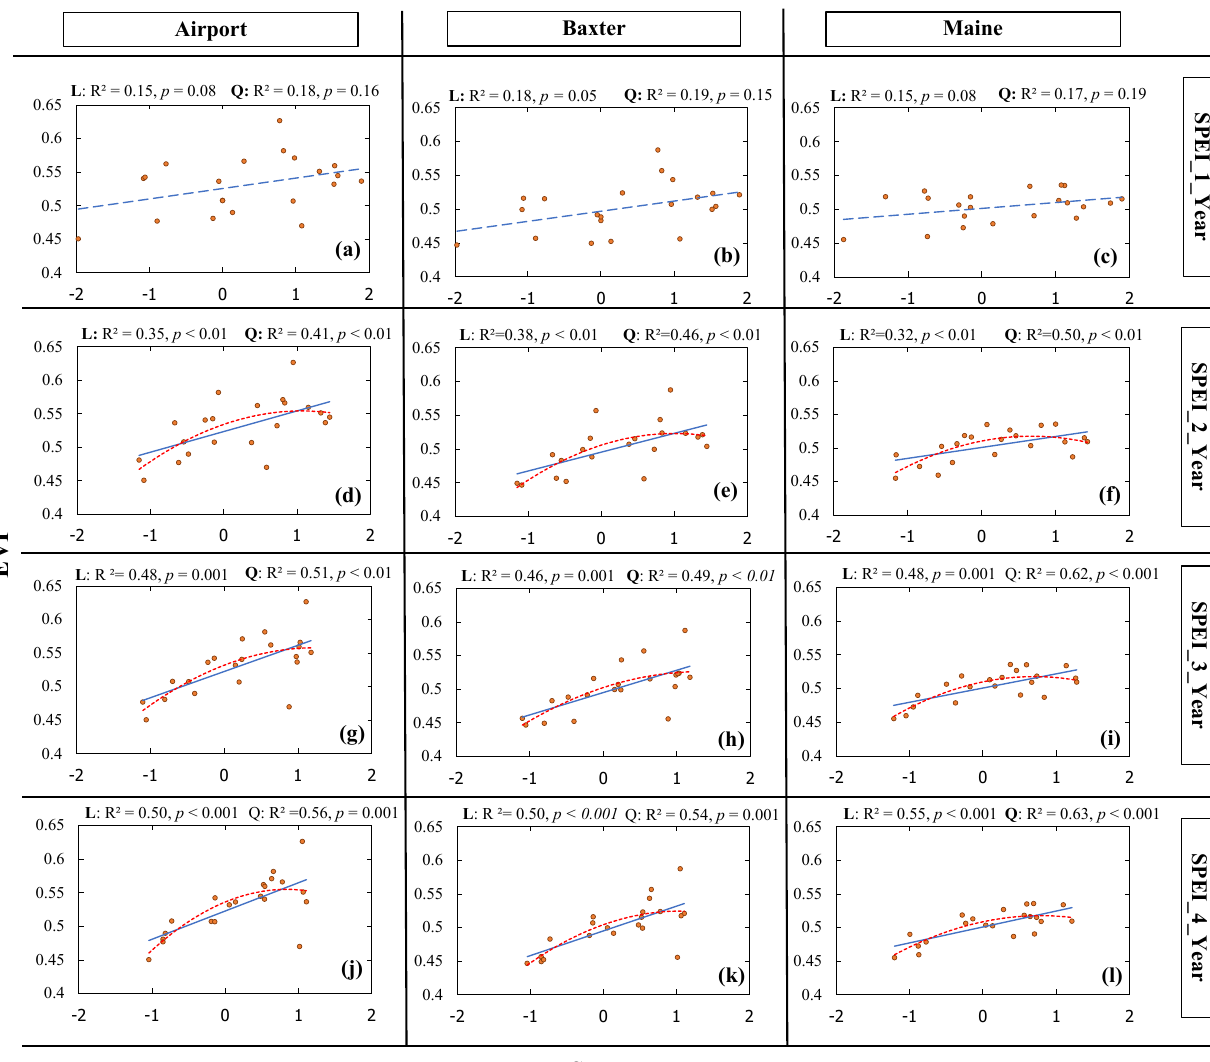
Figure 6. Average enhanced vegetation index (EVI) of wild blueberry fields during the growing season (May to September) for three different study zones: Airport (irrigated), Baxter (non-irrigated), and the major wild blueberry production region in Maine in relation to ( a – c ) SPEI_1_Year; ( d – f ) SPEI_2_Years (average SPEI of two consecutive years); ( g – i ) SPEI_3_Years (average SPEI of three consecutive years); ( j – l ) SPEI_4_Years (average of SPEI of four consecutive years). Here, SPEI refers to SPEI_6 of September and it represents the SPEI (water conditions) of the growing season (April–September). A positive SPEI value represents wet conditions, while a negative SPEI value indicates dry conditions. The blue solid lines indicate significant ( p < 0.05) and blue dashed lines indicate marginally significant ( p < 0.10) linear relationships. The dashed red lines indicate significant ( p < 0.05) or marginally significant ( p < 0.10) quadratic relationships. The time period of the EVI and SPEI data was from 2000 to 2020.